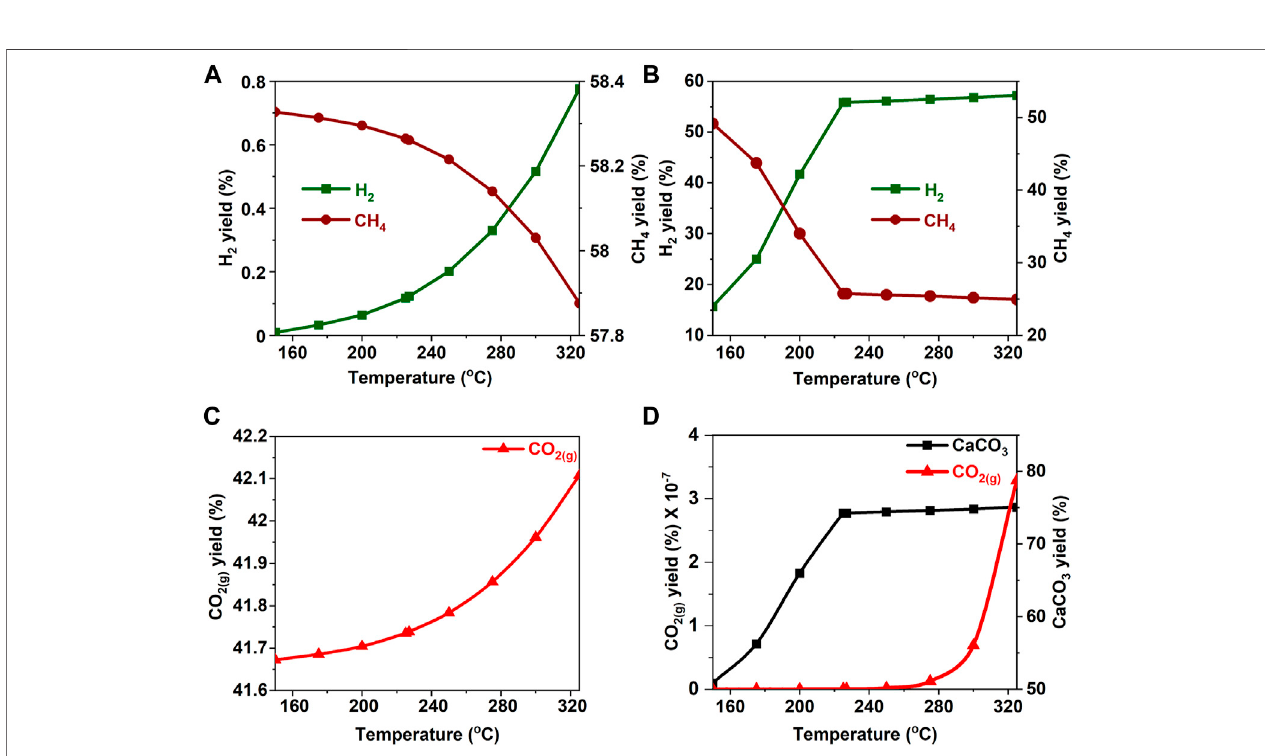
FIGURE11 | Effect oftemperature on the product yield from glycerol (A , C) in the absence and (B) in thepresence ofcalcium oxide. Theyieldof CO 2 post capture to produce calcium carbonate is represented in 9 (D) . These calculations are performed with temperatures of 227 ° C and pressures of 50 bar.